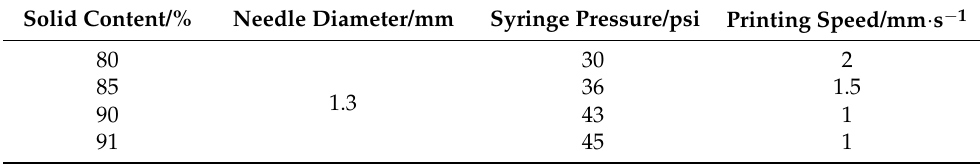
Table 2. Process parameters of components in printing process.